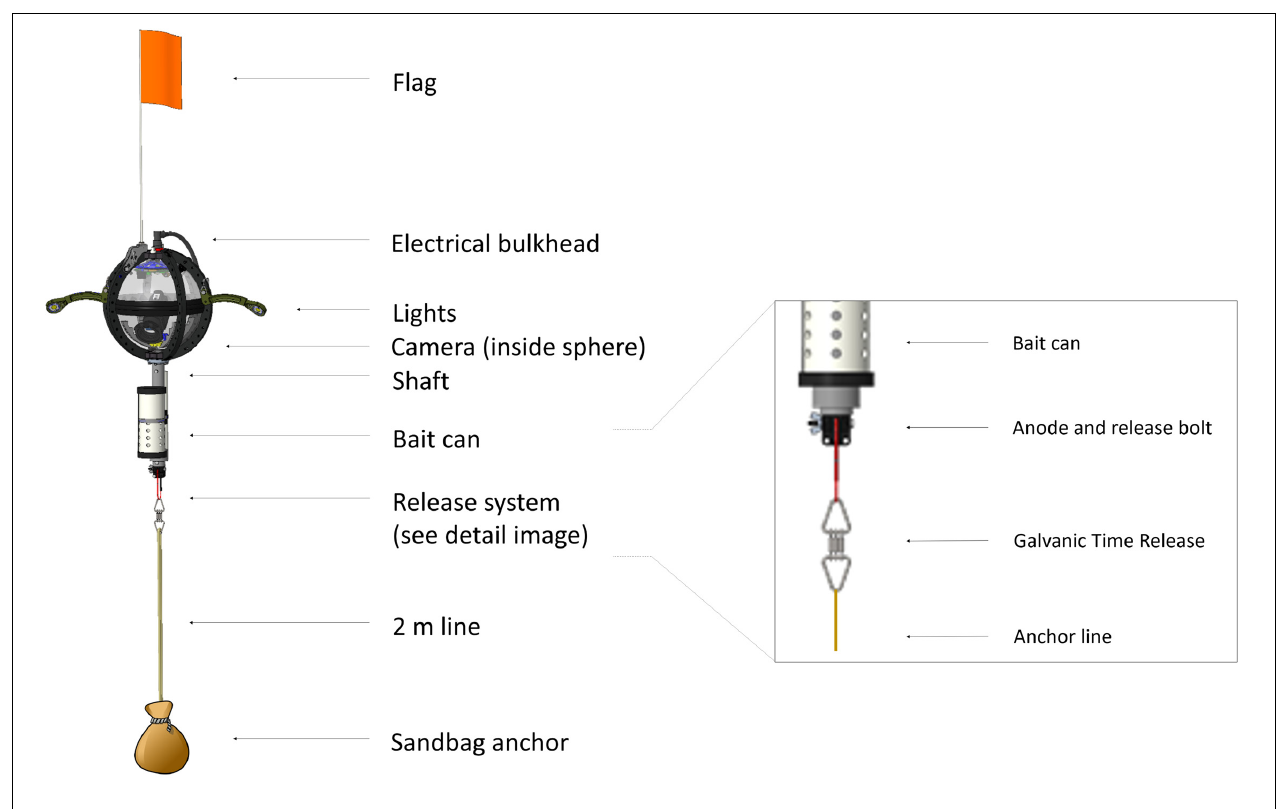
FIGURE 1 | Structural design of the NGS deep-sea camera system, with detail of the release